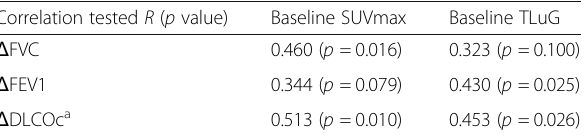
Table 4 Correlation of baseline SUVmax and TLuG with change in lung function parameters, n = 27 Correlation tested R ( p value)